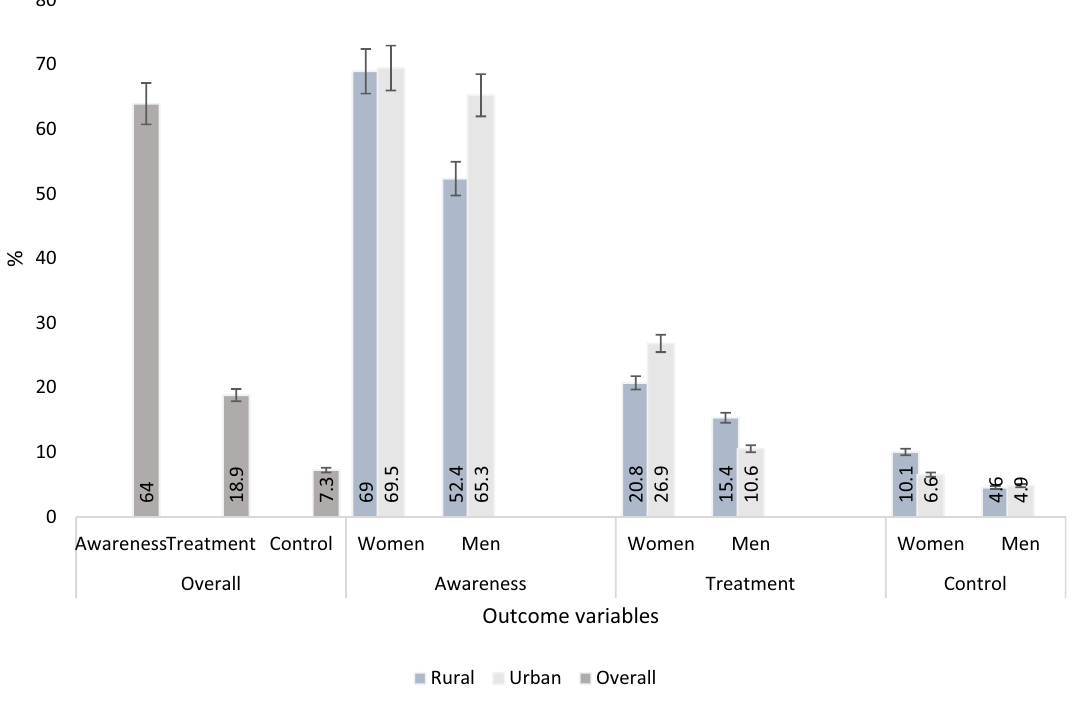
Figure 1. The overall, sex and rural/urban proportions of dyslipidemia awareness, treatment and control among the study